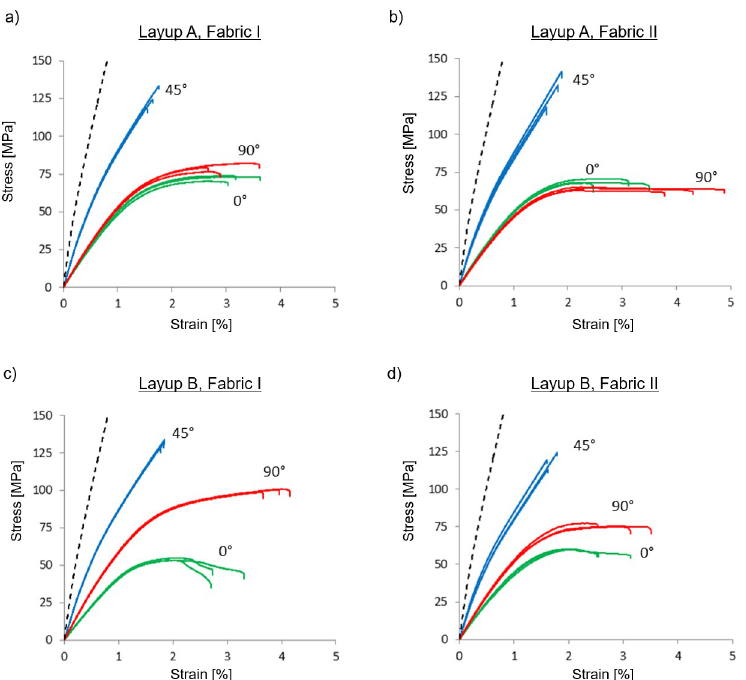
Fig 9. Measured stress-strain curves of the multiaxial flax fibre composite laminates with layup A: (a) fabric I and (b) fabric II, and with layup B: (c) fabric I and (d) fabric II. Shown are stress-strain curves for the three testing directions of 0˚, 45˚ and 90˚. For comparison, the initial part of the stress-strain curve of the uniaxial composite laminate is shown by a dotted line.